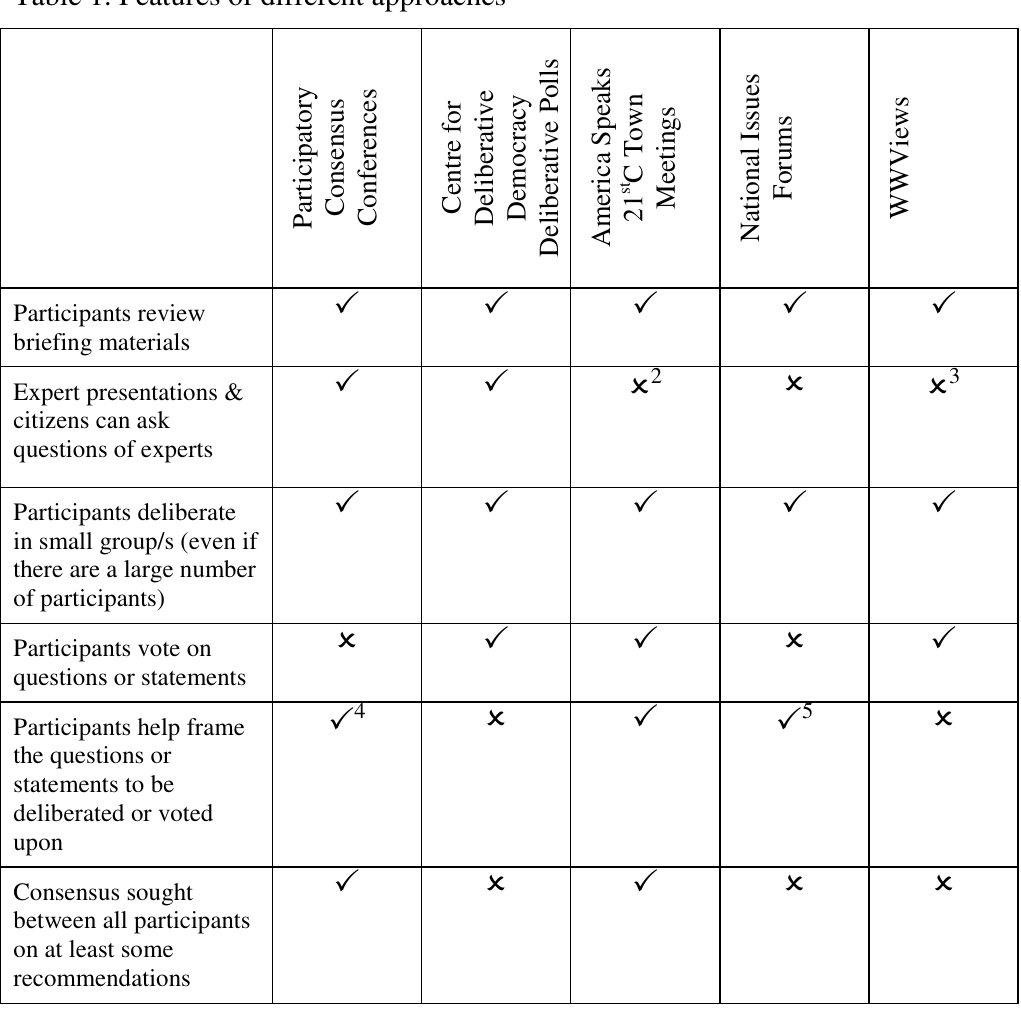
Table 1. Features of different